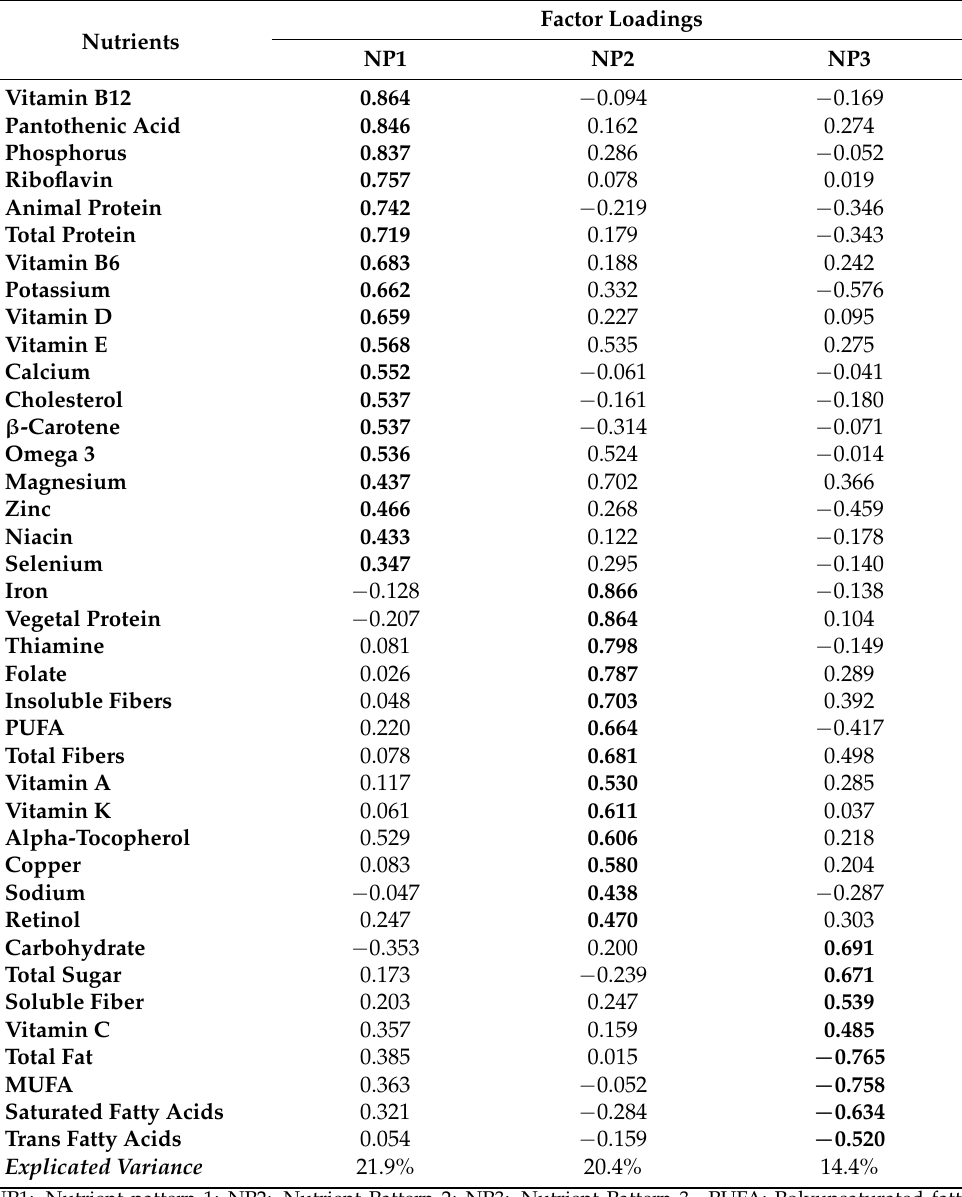
Table 3. Factor loadings of nutrients of the nutrient patterns identified in postmenopausal women.